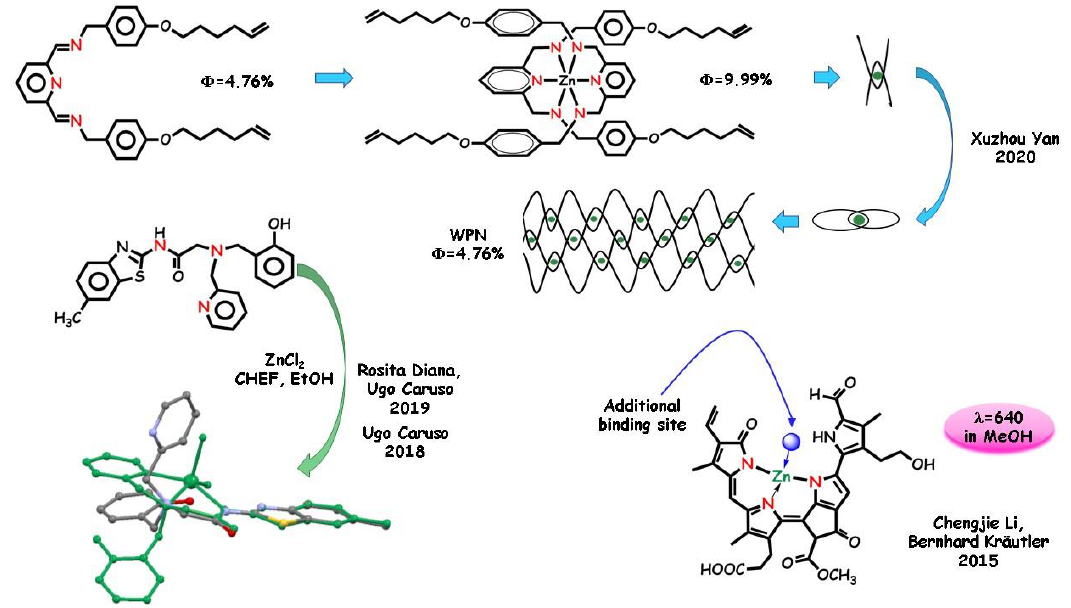
Figure 5. Supramolecular architectures produced from zinc-interlocked chains. Tridentate pincers for sensing analysis of zinc cations.